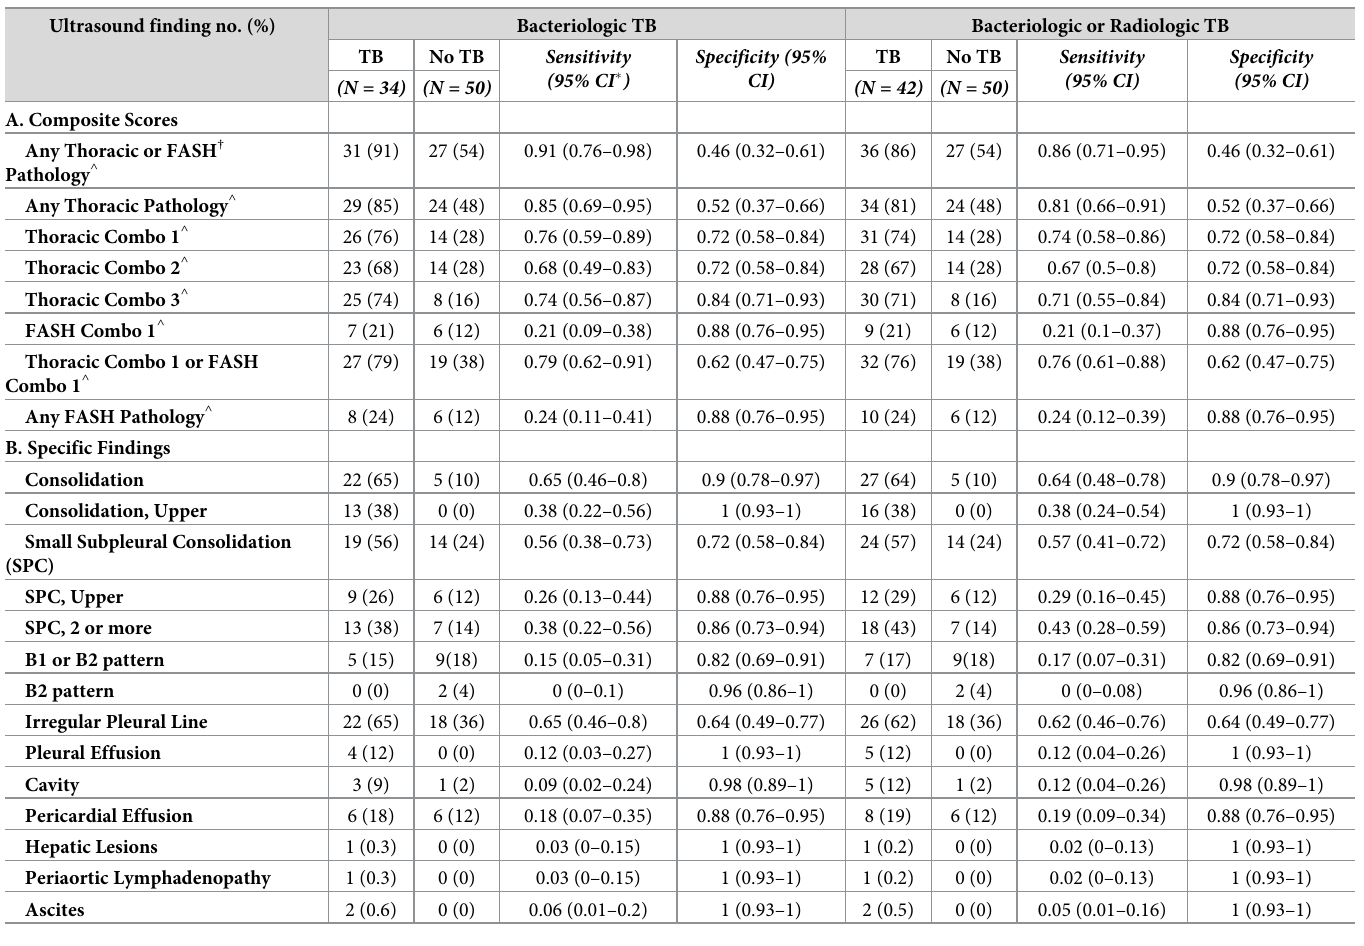
Table 3. Ultrasound findings in all participants stratified by TB